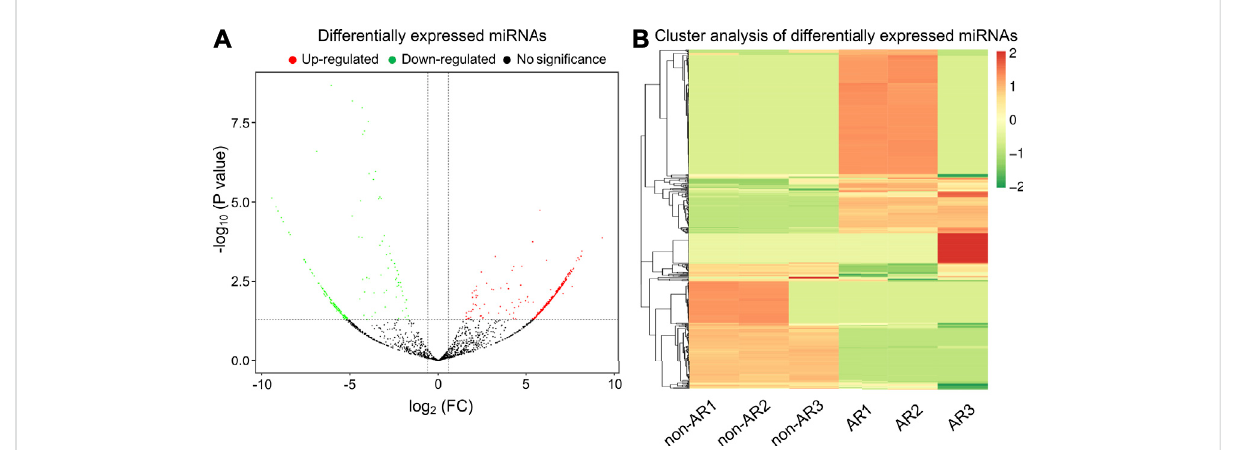
FIGURE 4 Volcano plot and heat map of differential expressed miRNAs obtained from the comparison of non-AR and AR patients. (A) Each point in the volcano plot represents one miRNA. Red points represent upregulated ones, green points represent downregulated ones, and dark points represent nosigni fi cantchangesinmiRNAs. (B) Theabscissarepresentsdifferentgroups,theordinaterepresentsthedifferentmiRNAscomparedinthegroups, and the color blocks at different positions represent the relative miRNA